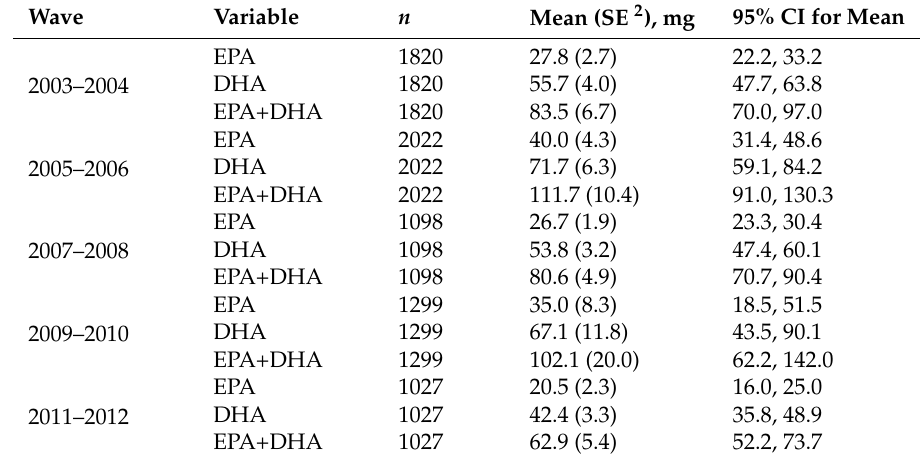
Table 2. Omega 3 fatty acid intake by NHANES wave 1